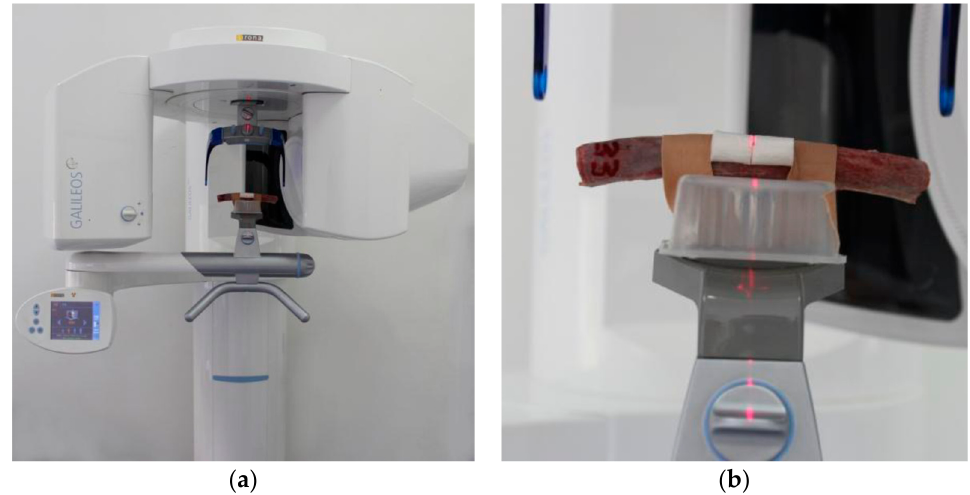
Figure 3. CBCT scanner GALILEOS Comfort plus ( a ) and specimen positioned for scanning ( b ).